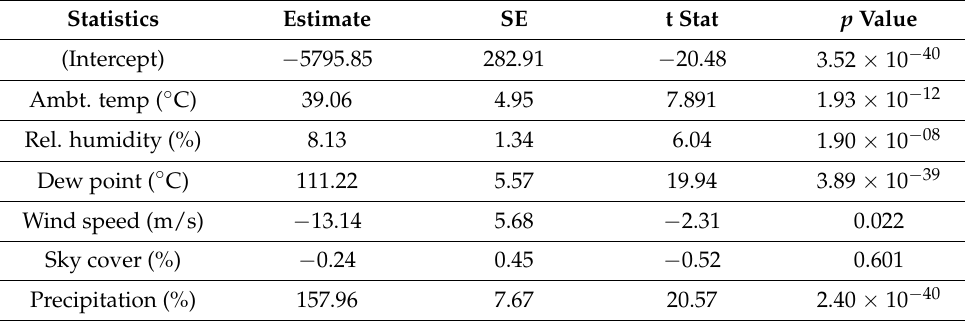
Table 3. Initial regression results for irradiance prediction.